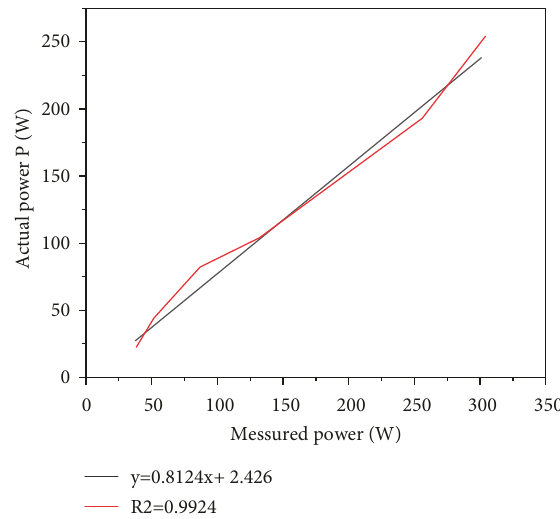
Figure 4: The relationship between the time power P and the measured power at 60